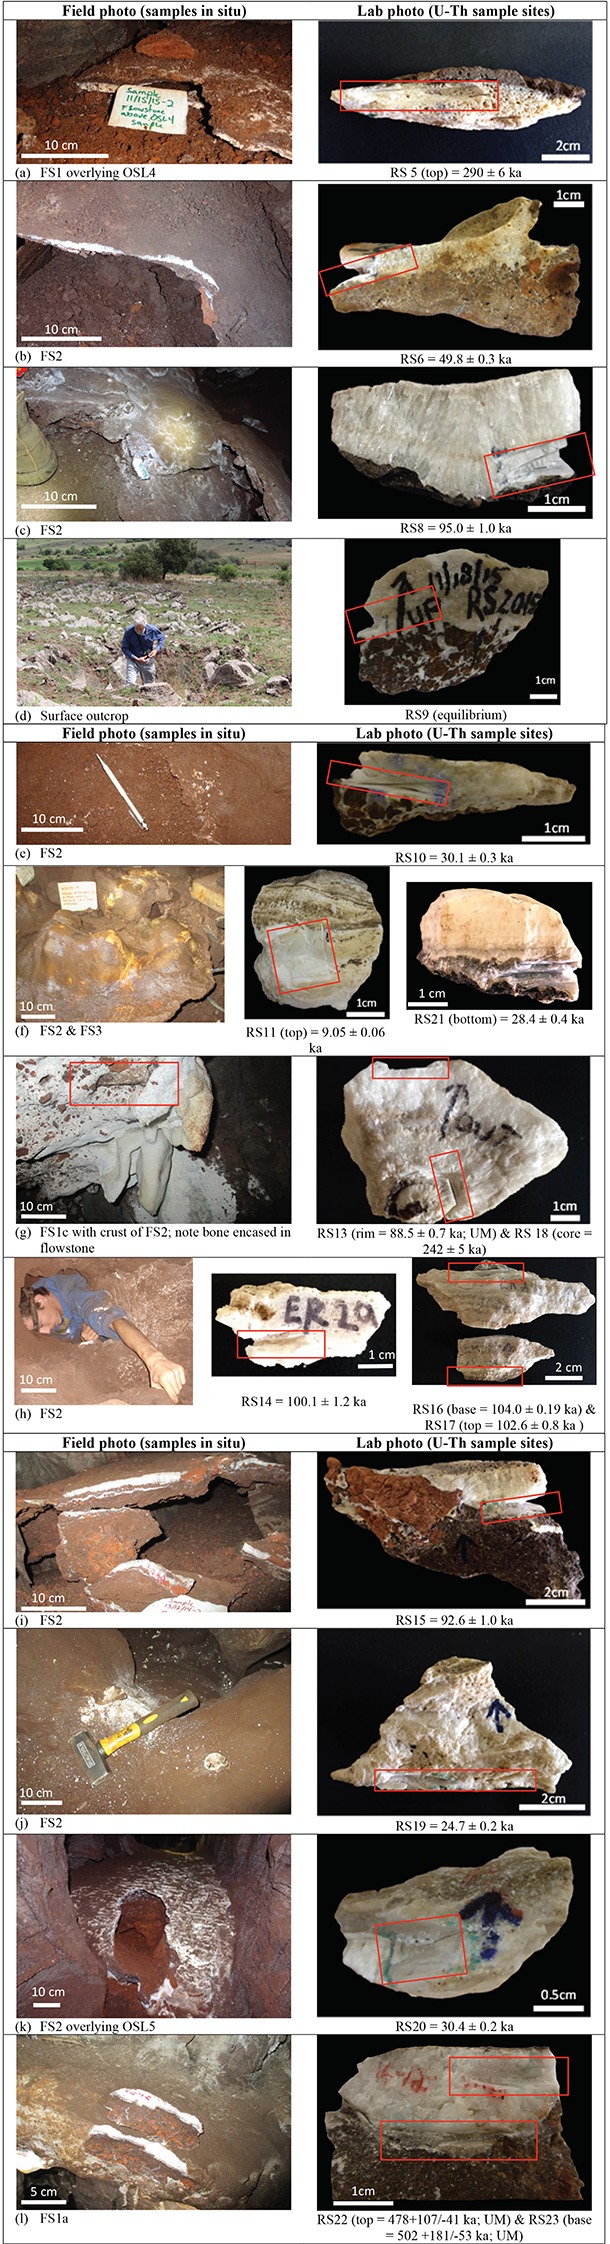
Field and close-up photographs of all flowstone samples collected for U-Th dating.The flowstone groups (i.e., Flowstone Groups 1, 2 or 3), sample numbers, and ages (2σ uncertainty), as listed in Table 1, are shown below each sample. Ages reported here are from JCU, unless otherwise stated.